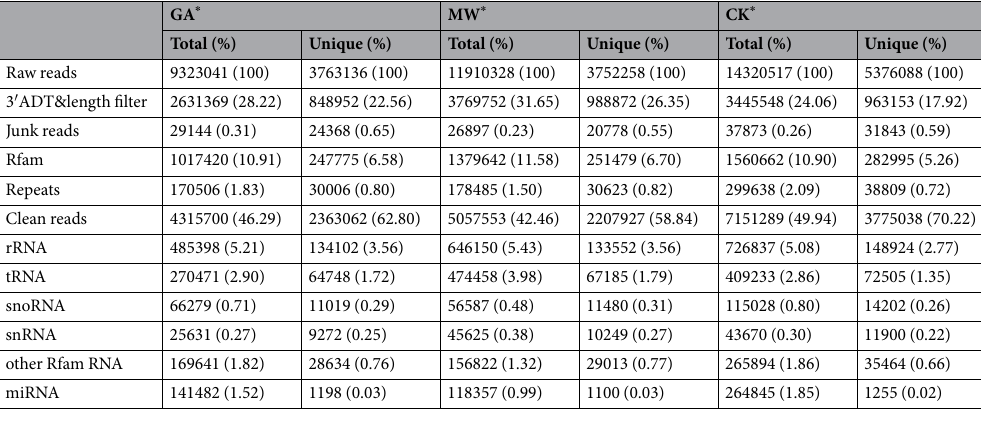
Table 1. Overview of reads from the raw data to cleaned sequences from small RNA libraries. * GA: geometrid- attacked, MW: mechanical-wounding, CK: